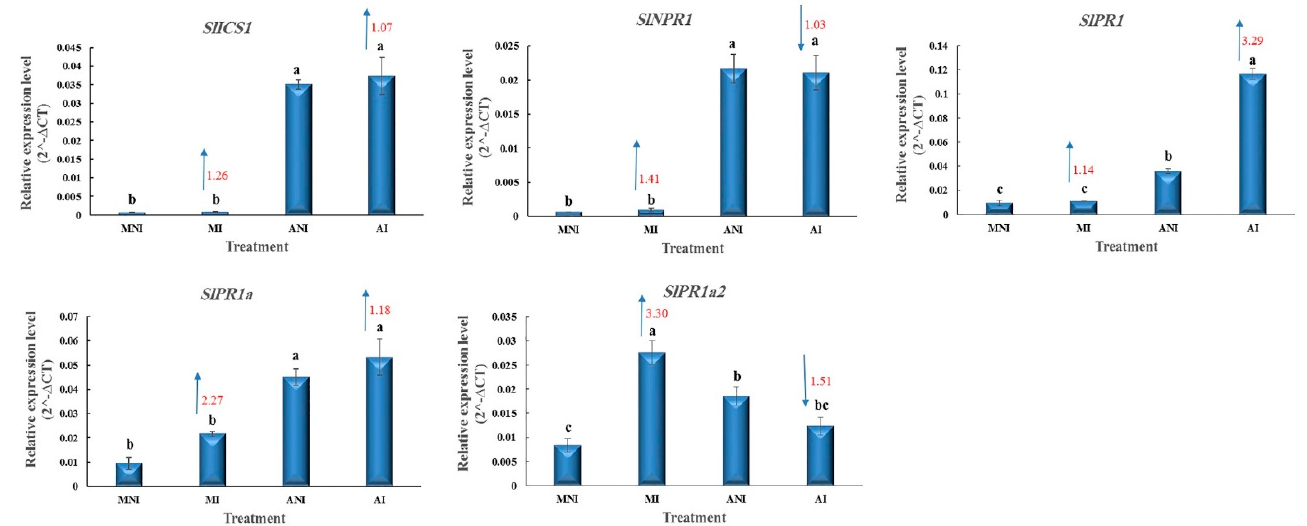
Figure 4. Analysis of the expression levels of salicylic acid-related genes in the roots of Dutch Mobil and ALYSTE F-1 (as highly susceptible and moderately resistant tomato cultivars, respectively) at 14 days after inoculation with Meloidogyne javanica . Gene expression was measured using quantita- tive real-time PCR (qRT-PCR). Five biological replicates for each treatment were considered in an experiment, and each biological replicate contained three technical replicates. The experiment was performed three times independently. Tubulin alpha-3 chain ( TAC ) was used as a reference gene for the normalization of qRT-PCR data. The transcript levels were calculated according to the 2 −∆ CT method. The bars represent the means 2 −∆ CT ± SE. The numbers displayed in the graph (in red) with blue arrows indicate the fold change (increase or decrease in the expression of genes of each cultivar compared to the corresponding control based on 2 – ∆∆ CT ). The means with different letters within each column are significantly ( p ≤ 5%) different according to the Fisher’s least significant difference (LSD) test. MNI: Dutch Mobil non-inoculated, MI: Dutch Mobil inoculated, ANI: ALYSTE F-1 non-inoculated, AI: ALYSTE F-1 inoculated, ICS1: isochorismate synthase1, NPR1: non-expresser of pathogenesis-related genes1 , PRs ( PR1, PR1a, and PR1a2 ): pathogenesis-related